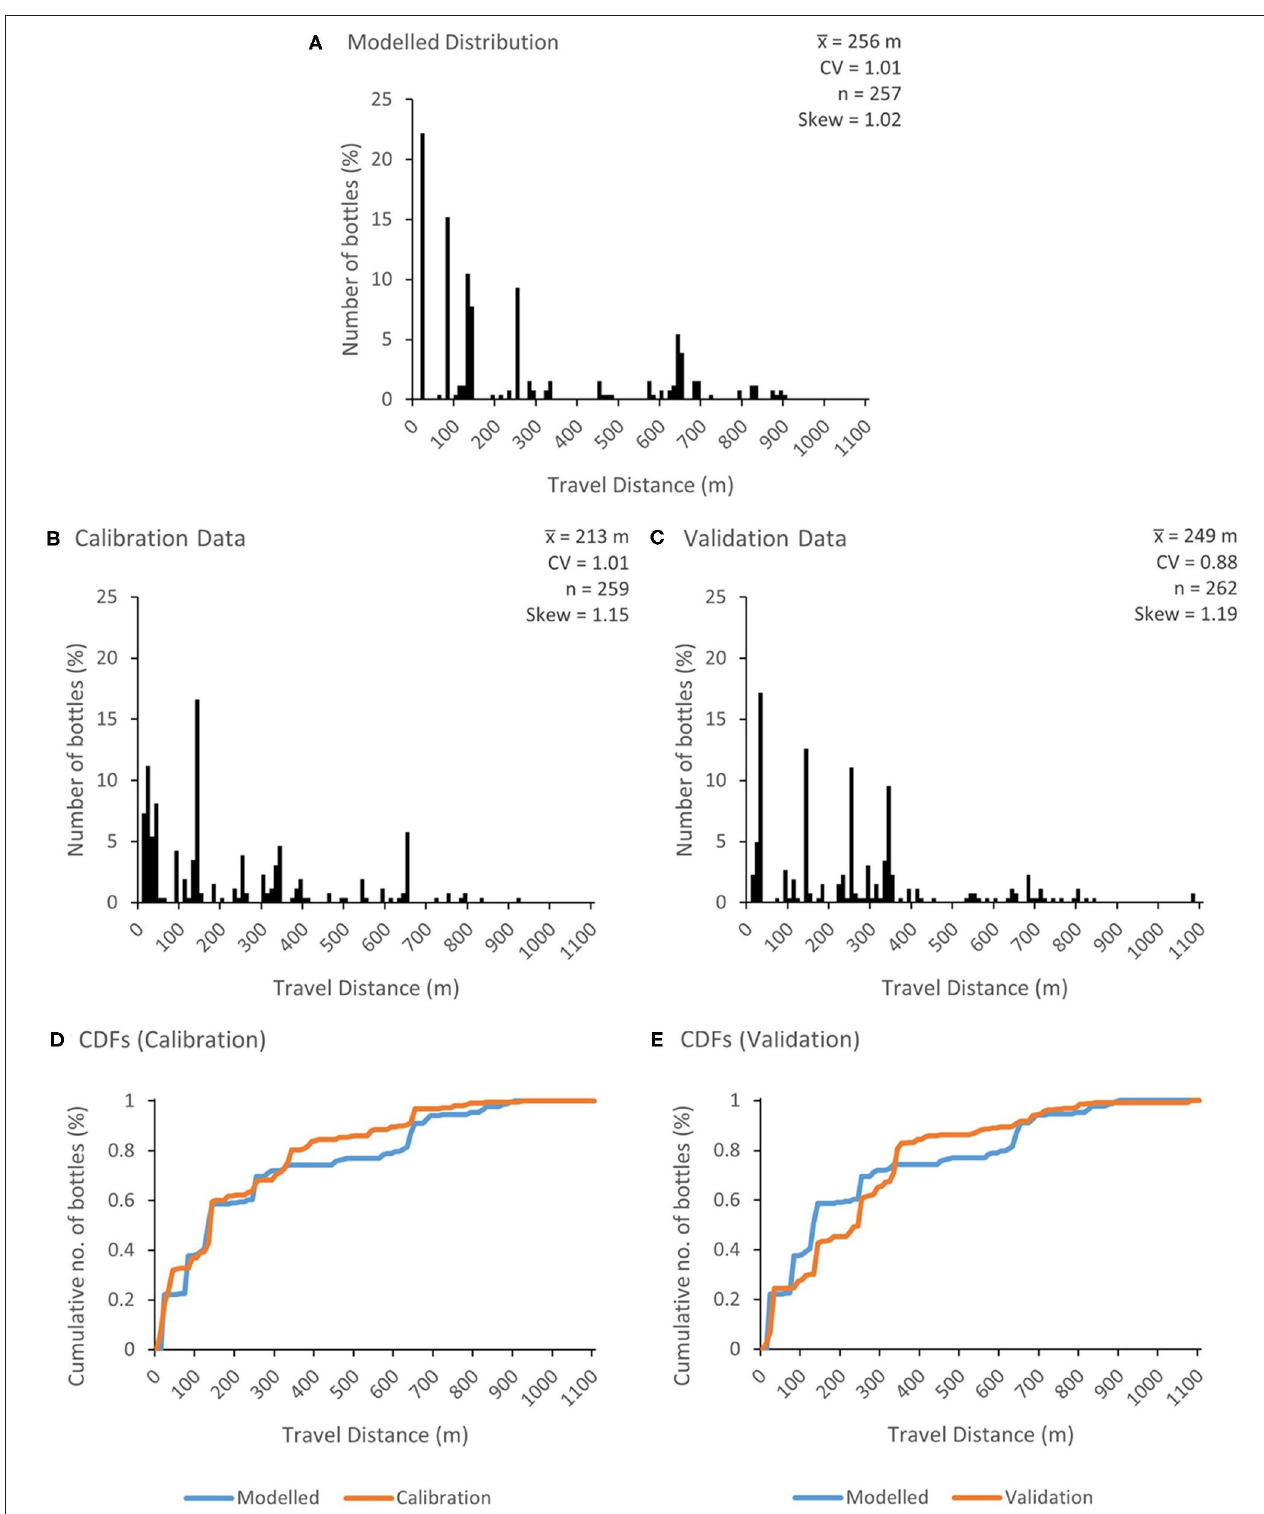
FIGURE 4 | Travel distance distributions of plastic bottles after 24h for (A) the optimum combination of parameters ( a = 0.3, b = 6, c = 5, and p ( V ) = 0.2); (B) the calibration dataset and (C) the validation dataset. The cumulative distribution functions (CDFs) for travel distances in the calibration and validation datasets are shown in (D,E) , respectively. x , mean travel distance; CV, coefficient of variation; n, number of bottles. Note that n is different in (A,B) due to the predicted loss of two bottles from (A) .